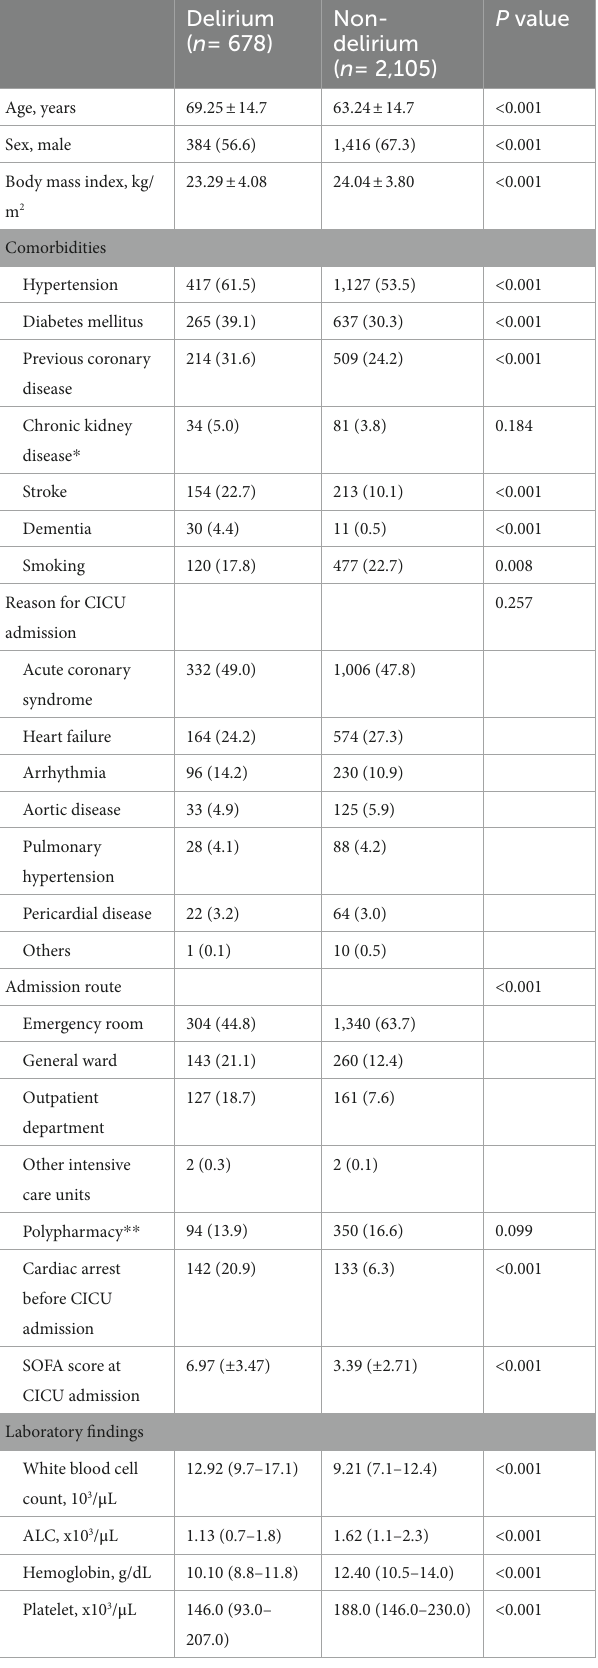
TABLE 1 Baseline characteristics of CICU